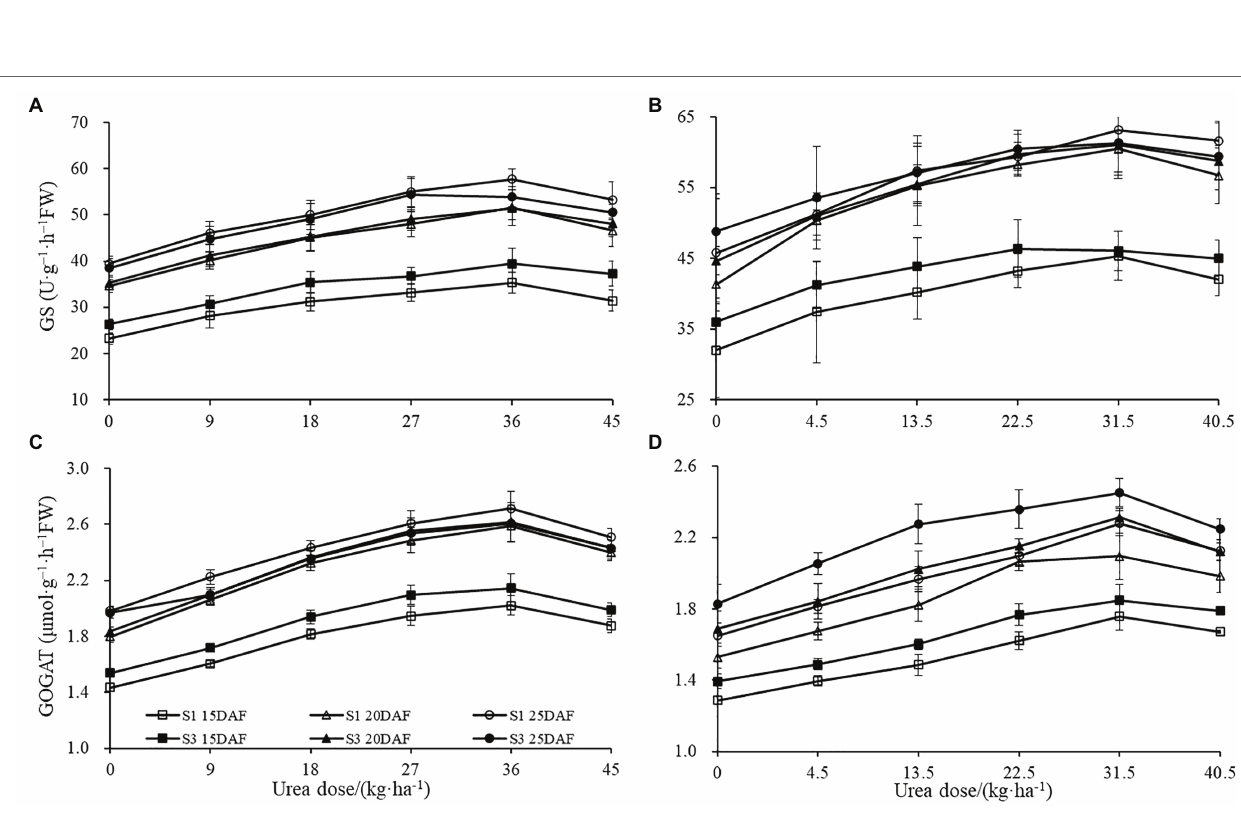
FIGURE 4 | The boll shell GS and GOGAT activity under different urea doses in 2017 (A,C) and 2018 (B,D) . GS represents the abbreviation of “glutamine synthetase,” GOGAT represents the abbreviation of “glutamate synthetase,” FW represents the fresh weight of sample, DAF represents the abbreviation of “days after flowering,” and S1 and S3 represent the Sikang 1 and Sikang 3,